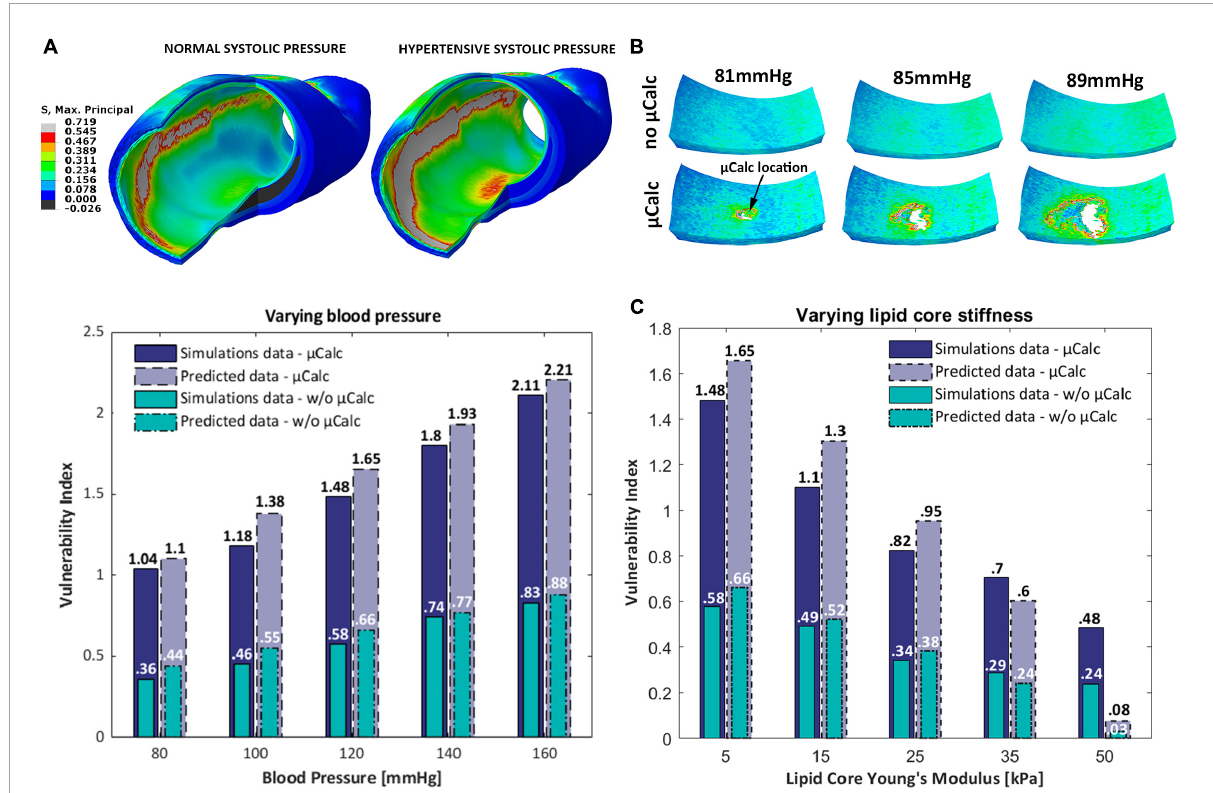
FIGURE7 (A) Isometric view of the Maximal Principal Stress distributions on the human coronary under normal and hypertensive blood pressure; (B) sequence of the cap segment submodel with and without the µ Calc. In the presence of the µ Calc, the cap rupture extensively, starting at the location of the µ Calc; (C) 3D-barplot of the change of the vulnerability index for different blood pressures, lipid core stiffness and the presence of one spherical µ Calc from FEM analyses and predicted by the statistical